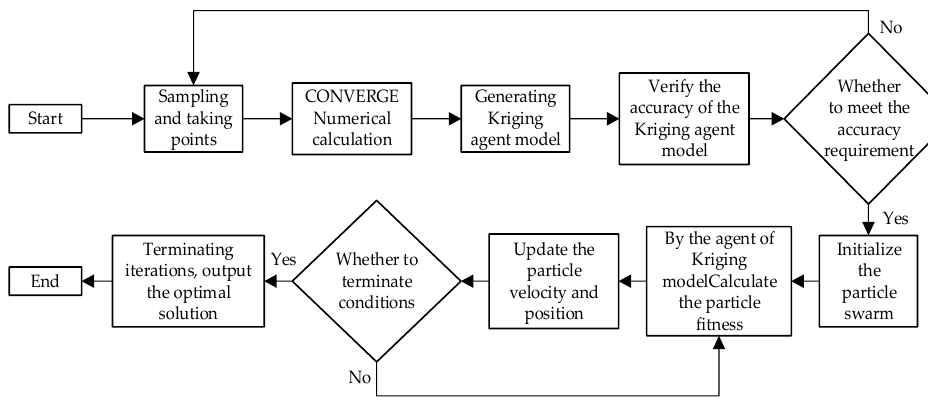
Figure 3. Flow chart of the PSO algorithm.